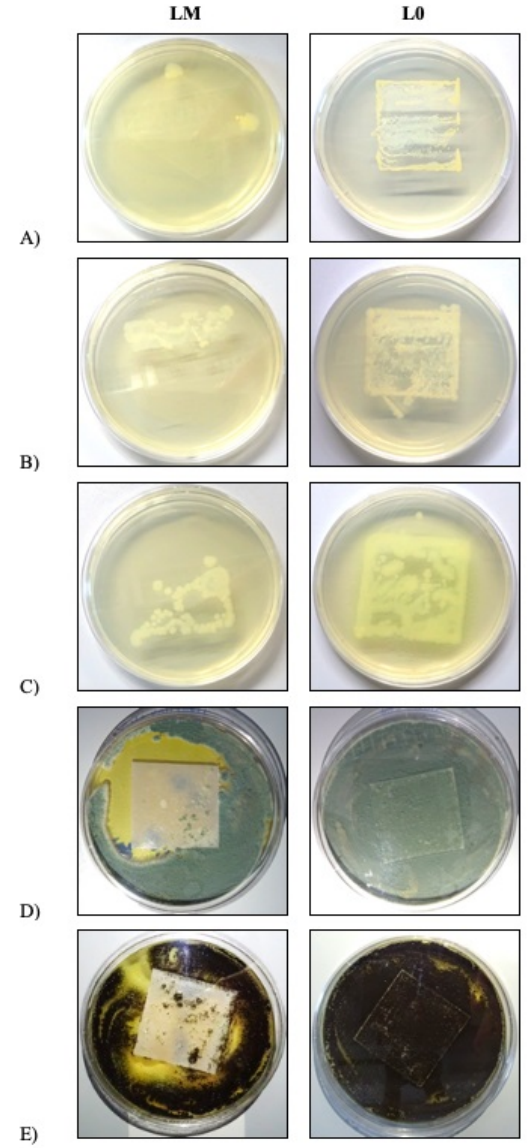
Figure 5. Visualization of antimicrobial activity of non-pigmented coating films against: ( A ) S. aureus , ( B ) E. coli , ( C ) P. aeruginosa , ( D ) P. chrysogenum , ( E ) A. brasiliensis